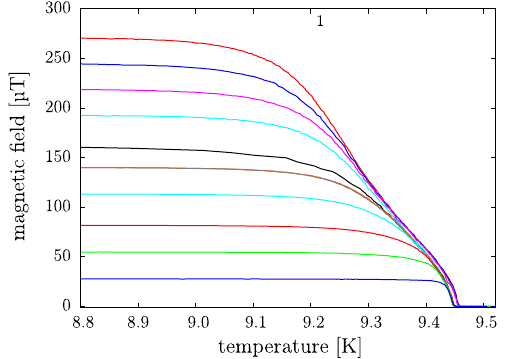
FIG. 10. Progression of the temperature gradient and the mag- netic field due to the Seebeck effect superimposed with the heater fields for both current directions. The heater was switched on at t ¼ 120 s to establish a temperature gradient. It was switched off at t ¼ 1120 s